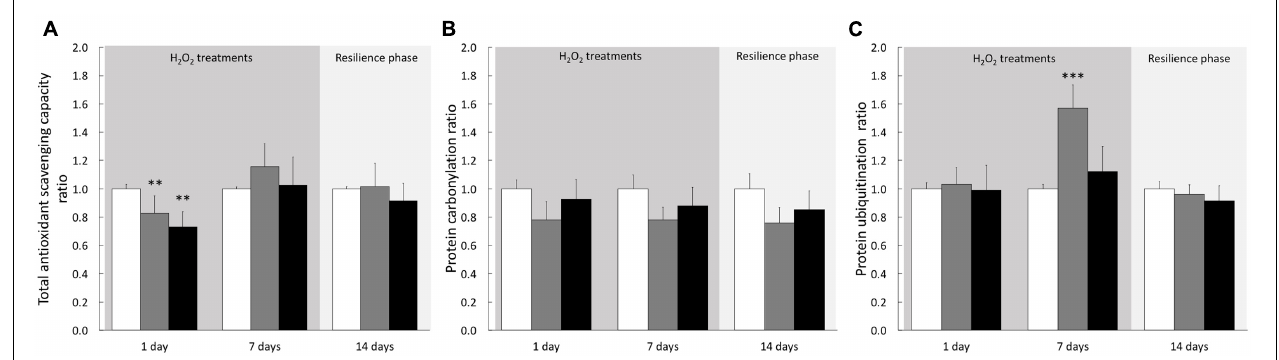
FIGURE 7 | Stress biomarkers in A. viridis cultivated cells under H 2 O 2 treatments and resilience phase. Total Oxidative Scavenging Capacity, TOSC (A) , protein carbonylation (B) and protein ubiquitination (C) were measured under cell treatment with H 2 O 2 at 200 and 500 µ M and during resilience phase (back to control condition for 7 days): 0 µ M H 2 O 2 (control; white bars), 200 µ M H 2 O 2 (gray bars) and 500 µ M H 2 O 2 (black bars). Data are expressed relative to control condition (ratio of the control condition). Means values with standard error bars are presented. Significant differences between control and treatments are expressed by ∗∗ p < 0.01 and ∗∗∗ p <